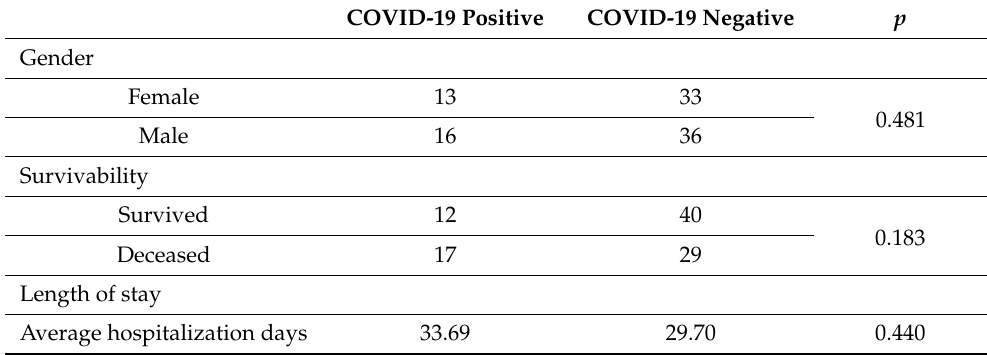
Table 4. Distribution of gender, survivability, and length of stay among patients with SARS-CoV-2 pneumonia and Enterococcus spp. co-infection.